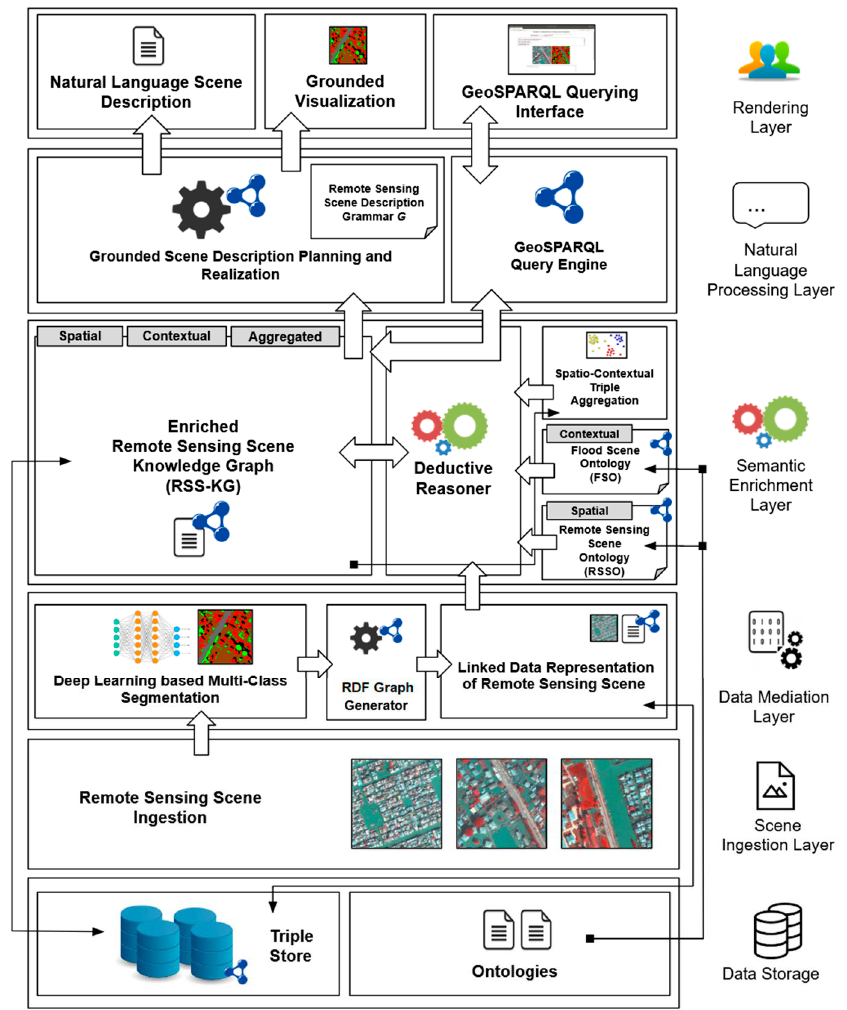
Figure 2. System architecture of the Semantics-driven Remote Sensing Scene Understanding (Sem- RSSU)